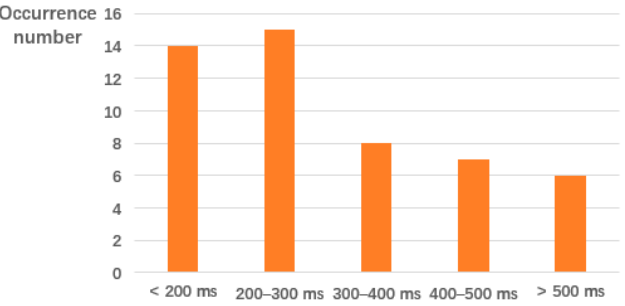
Figure 10. Distribution of data response time when the requested data do not exist in Ba-ITS.